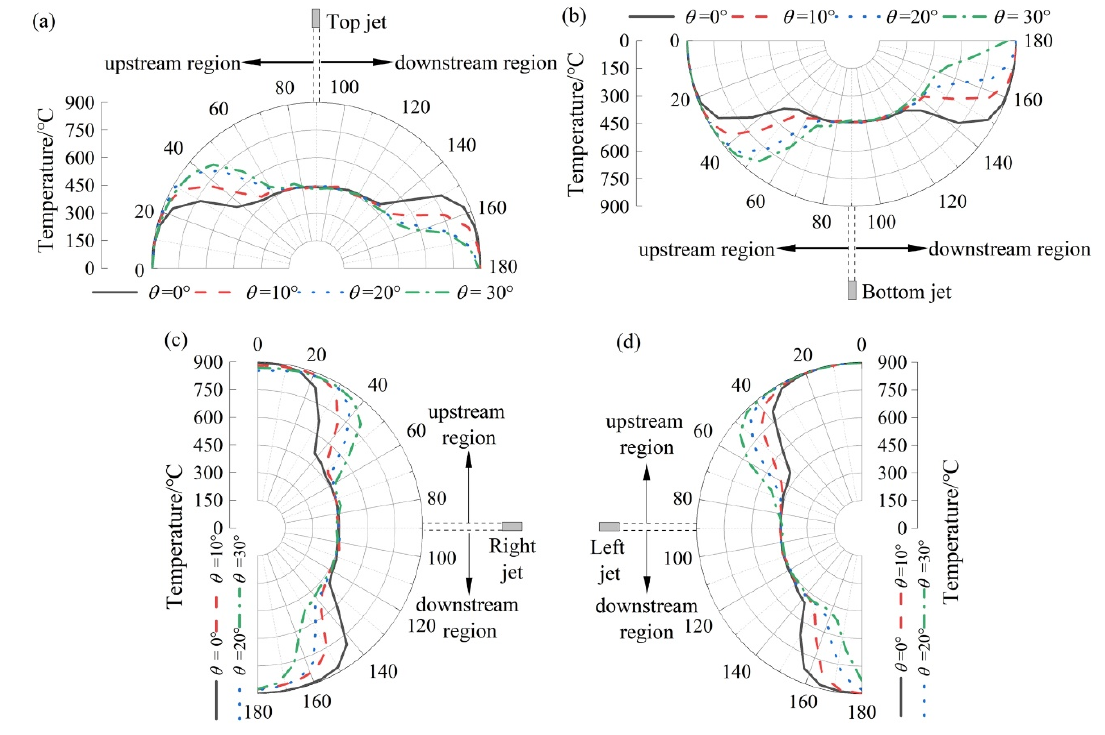
Figure 9. Temperature distribution in the circumferential direction of steel tube. ( a ) Top jet; ( b ) bot-